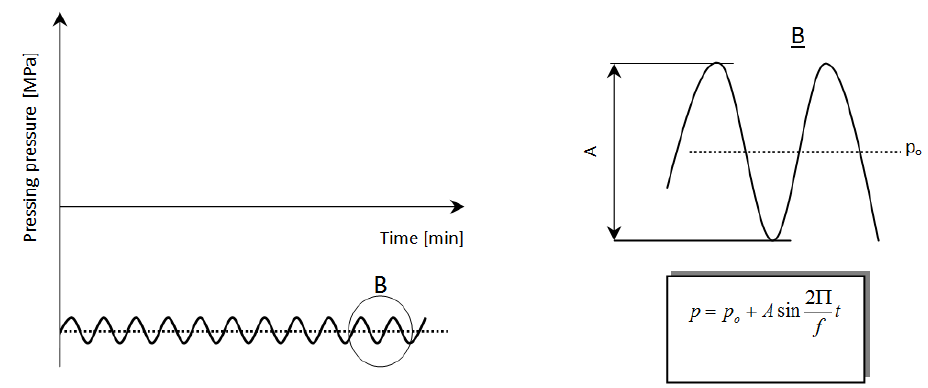
Figure 7. A schematic presentation of cyclic changes of the pressing pressure; where: p o : assumed level of pressing pressure (MPa); A : amplitude of the pressing pressure (MPa); f : frequency of the pressing pressure changes (Hz); t : time